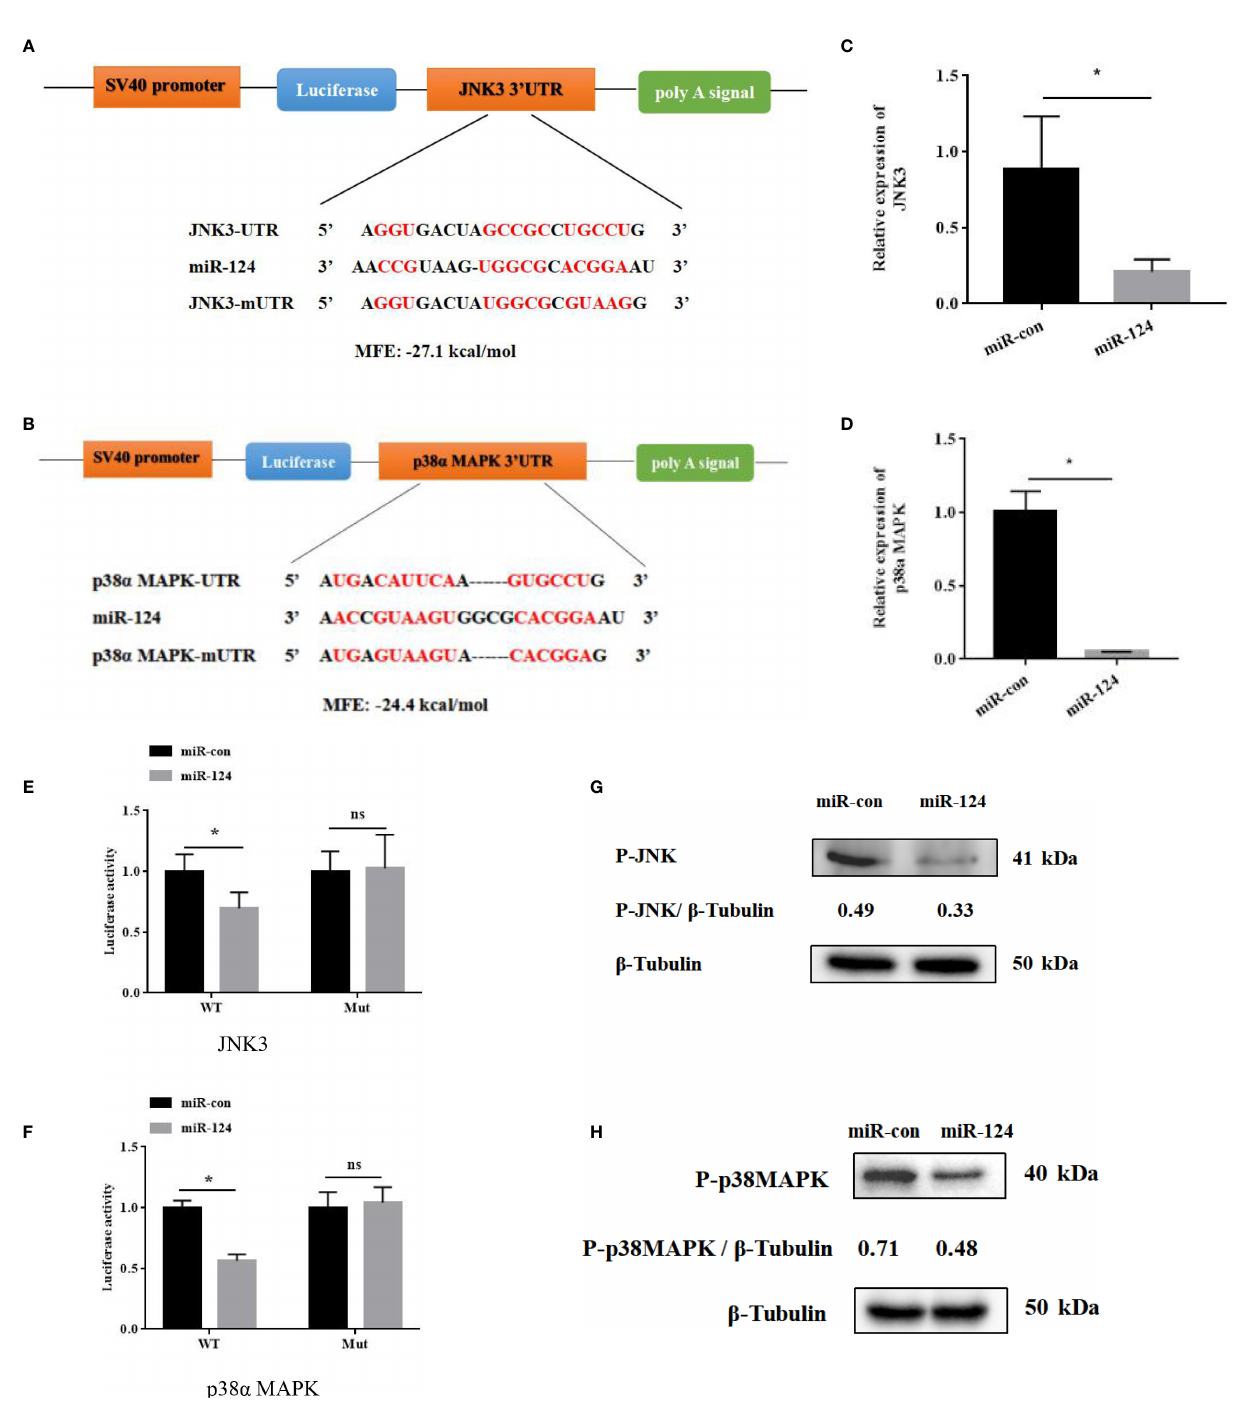
FIGURE 5 | JNK3 and p38 a MAPK were identi fi ed as the targets of miR-124. (A) Diagram of JNK3 3 ′ UTR-containing reporter constructs. (B) Diagram of p38 a 3 ′ UTR-containing reporter constructs. (C) The mRNA levels of JNK3 were reduced in GS cells treated with miR-124 mimics for 24 h. Actin was used as internal reference. (D) The mRNA levels of p38 a were reduced in GS cells treated with miR-124 mimics for 24 h. b -Actin was used as internal reference. (E) The 3 ′ UTR reporter assay was performed in GS cells 24 h after transfection. (F) The 3 ′ UTR reporter assay was performed in GS cells 24 h after transfection. (G) The level of P-JNK3 proteins was detected by Western blotting, the band intensity was calculated, and ratios of target protein/ b -tubulin were assessed by ImageJ software. (H) The level of P-p38 MAPK proteins was detected by Western blotting, the band intensity was calculated, and ratios of target protein/ b -tubulin were assessed by ImageJ software. Control mimics, miR-con; miR-124 mimics, miR-124; control inhibitors, in-con; miR-124 inhibitors, in-124. All data are presented as mean ± SD, N = 4. Compared with the control group, signi fi cant difference of experimental group is indicated with *( P < 0.05), and no signi fi cant difference is indicated with ns ( P >